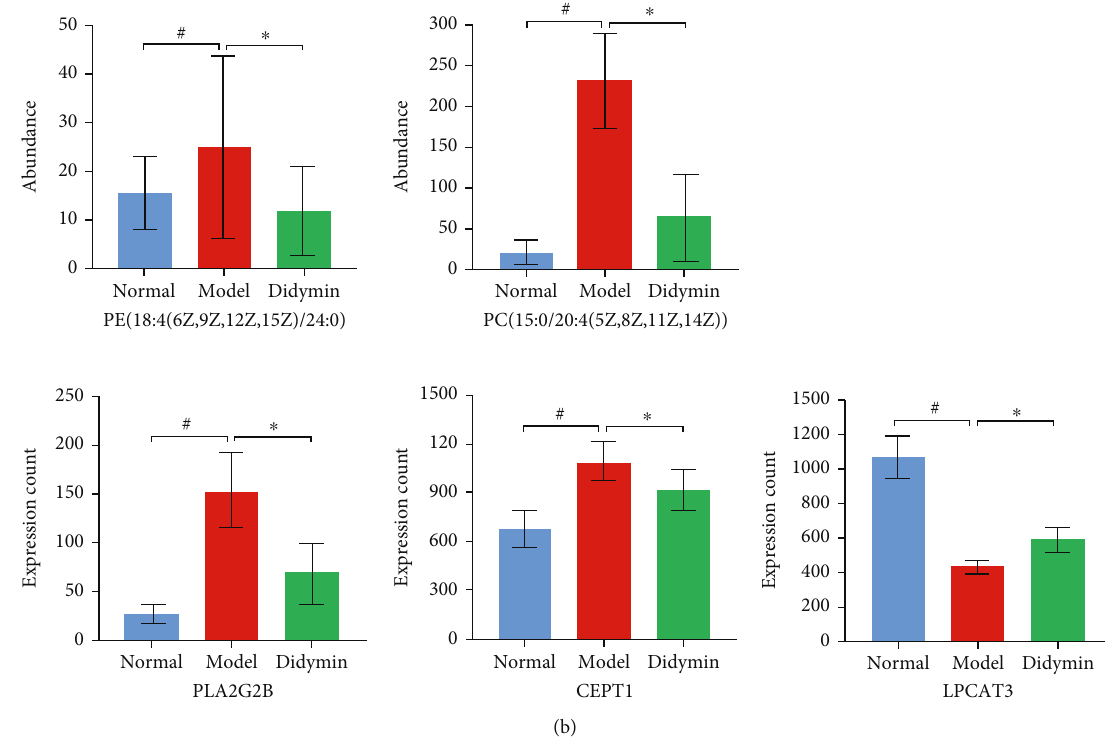
Figure 10: The integrative analysis of transcriptome and metabolome was conducted by MetaboAnalyst 5.0. (a) The glycerophospholipid metabolism pathway. (b) The contents of PE (18 :4 (6Z,9Z,12Z,15Z)/24 :0) and PC (15 :0/20 :4 (5Z,8Z,11Z,14Z)) and the expression levels of PLA2G4B, LPCAT3, and CEPT1. The data are presented as mean ± SD . # P < 0 : 05 vs. the normal group; ∗ P < 0 : 05 vs. the model